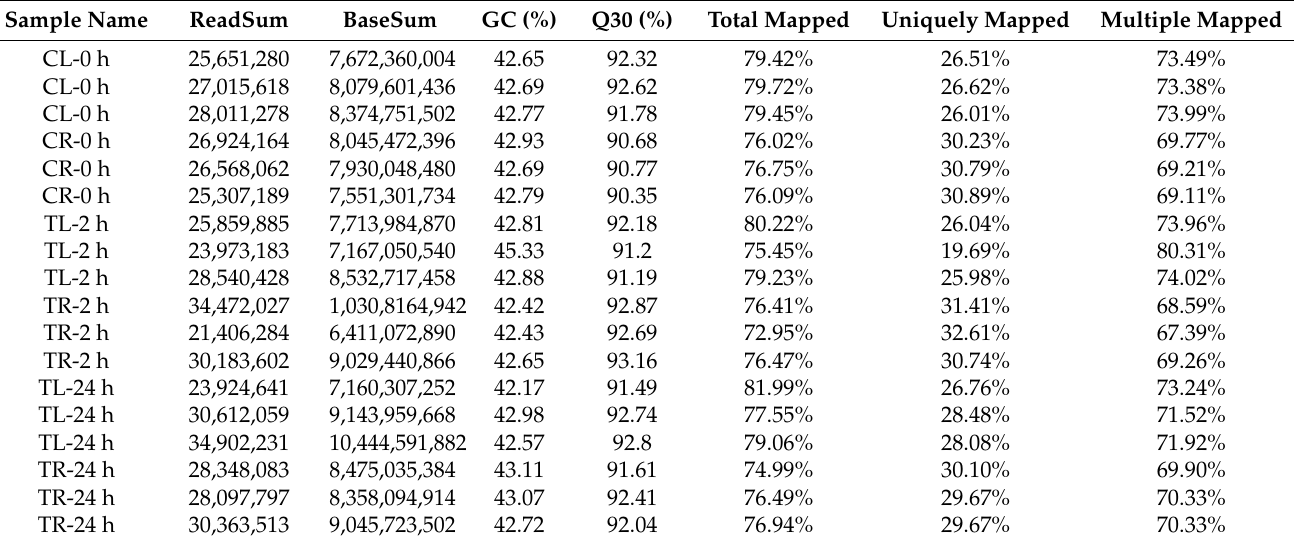
Table 1. Illumina HiSeq high-throughput sequencing results and mapping